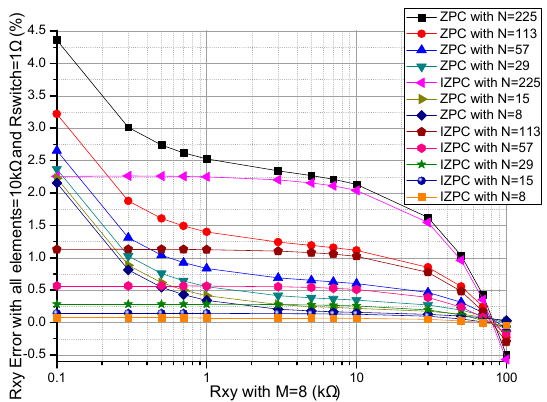
Figure 5. Effect of N on the R xy errors of the basic circuit and those of the improved circuit.